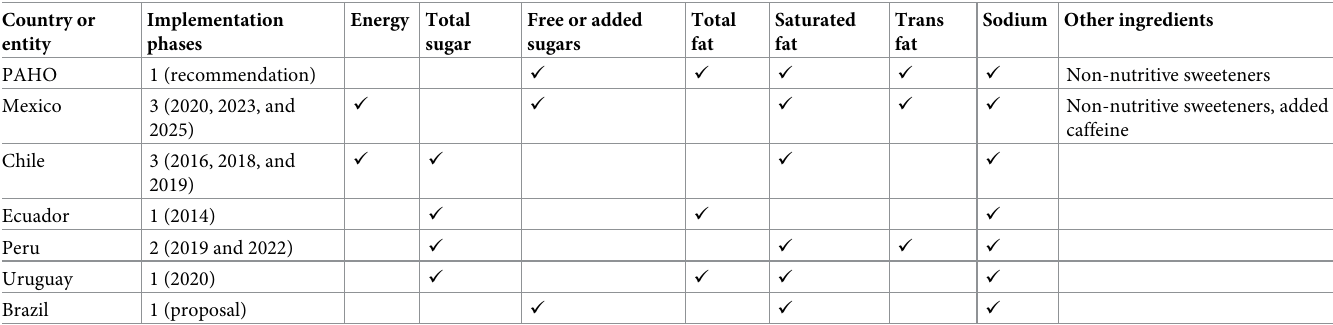
Table 1. Summary of nutrient profile (NP) models